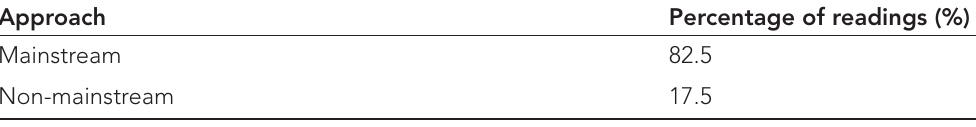
Table 4: Approach (Source: Authors, 2021)